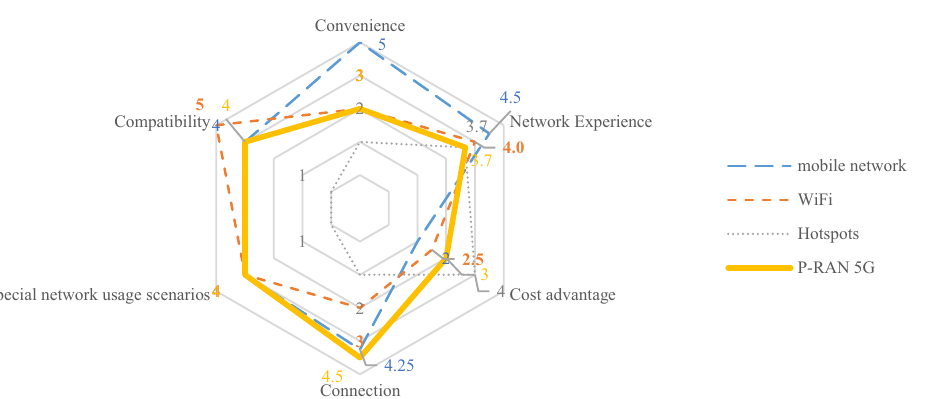
Figure 2. Results of value proposition evaluation of